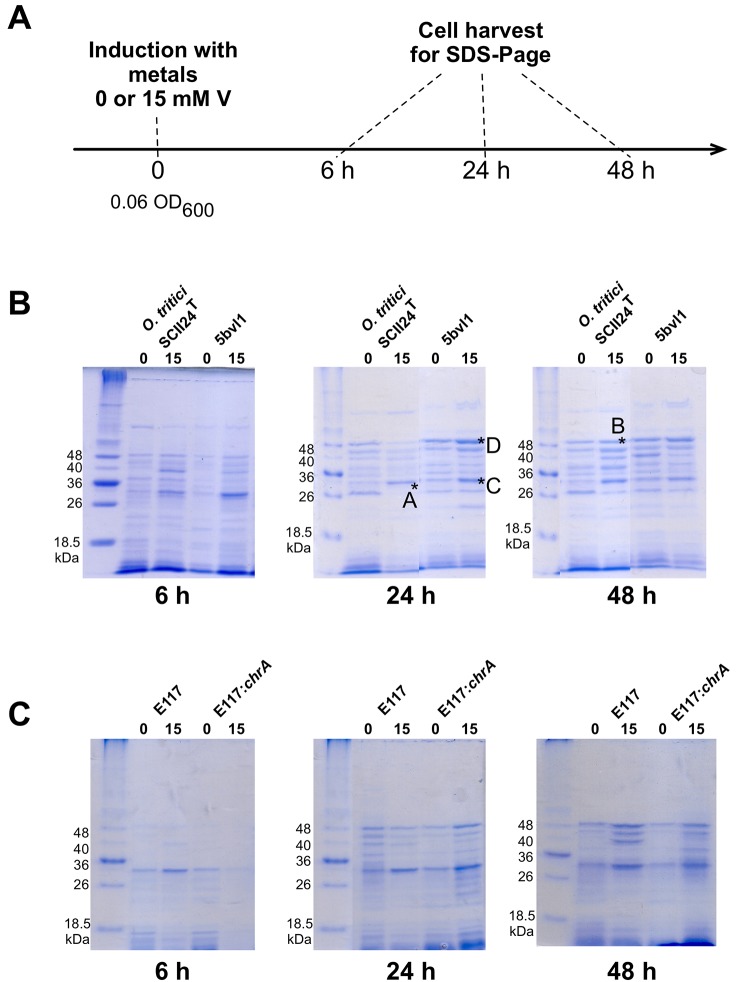
Total normalized protein profiles of O. tritici strains.(A) O. tritici SCII24T, 5bvl1, (B) E117 and E117:chrA strains after 6, 24 and 48 h growth at 30 °C in the absence or presence of 15 mM vanadate. *A, *B, *C and *D, represent bands cut for identification by LC-MS Orbitrap. Gels were grouped by incubation time.